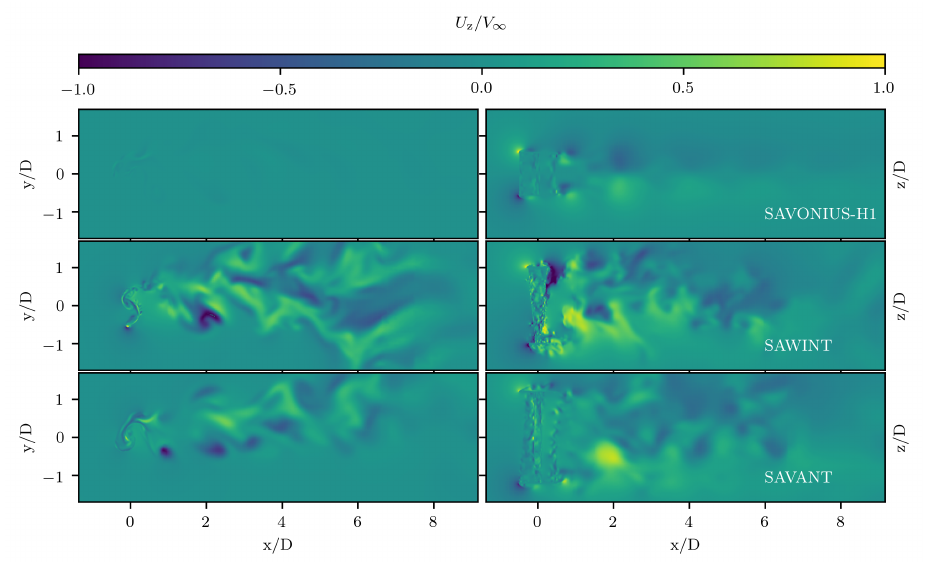
Figure 11. Instantaneous normalized streamwise ( top ) and vertical ( bottom ) velocity components in the horizontal and vertical middle plane, at optimal λ .